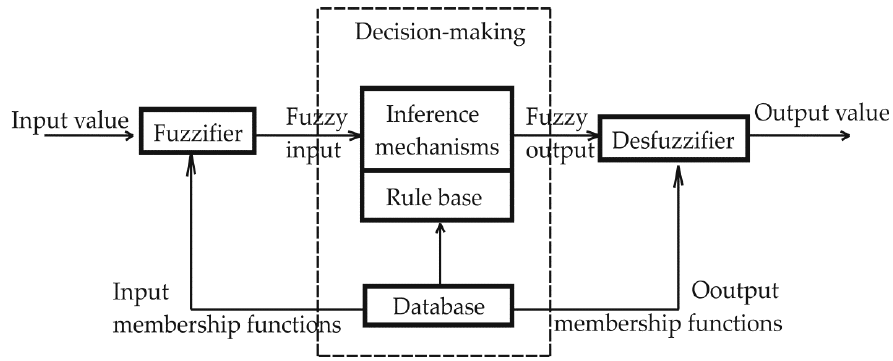
Figure A1. Structure of a FLC [99].